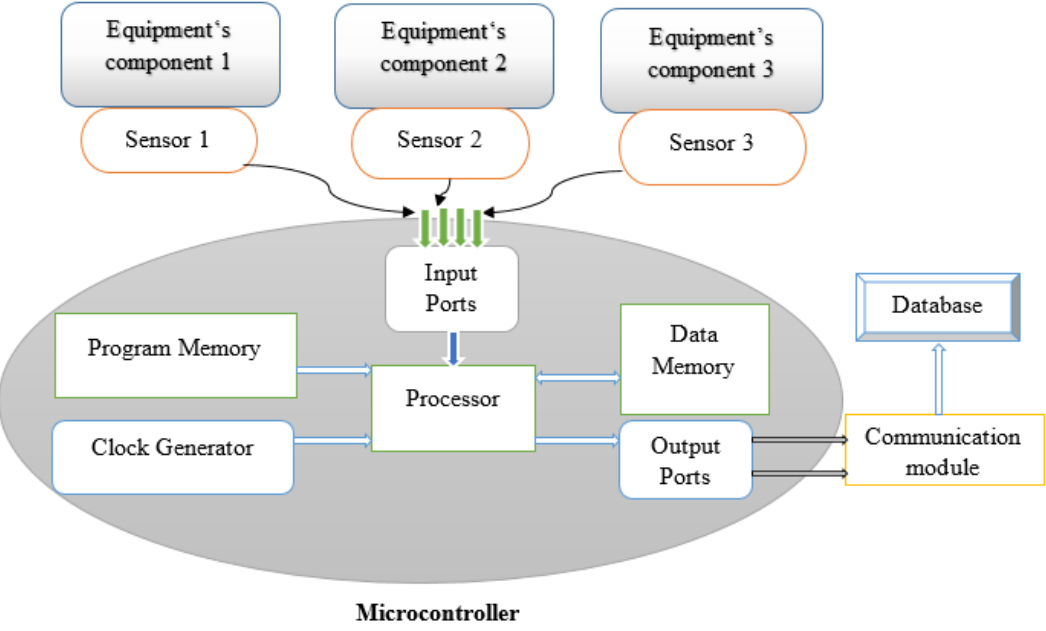
Figure 5. Data collector prototype main